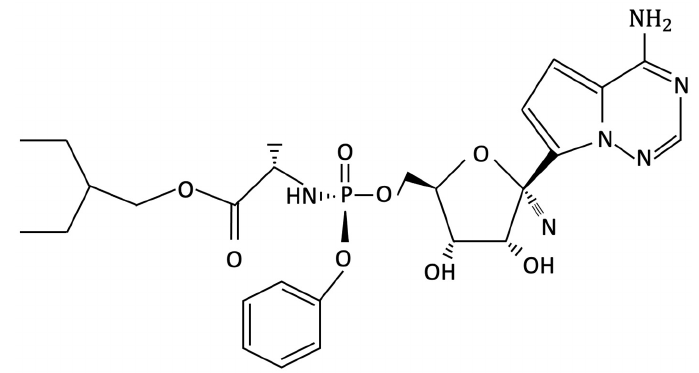
Figure 1. Remdesivir molecular